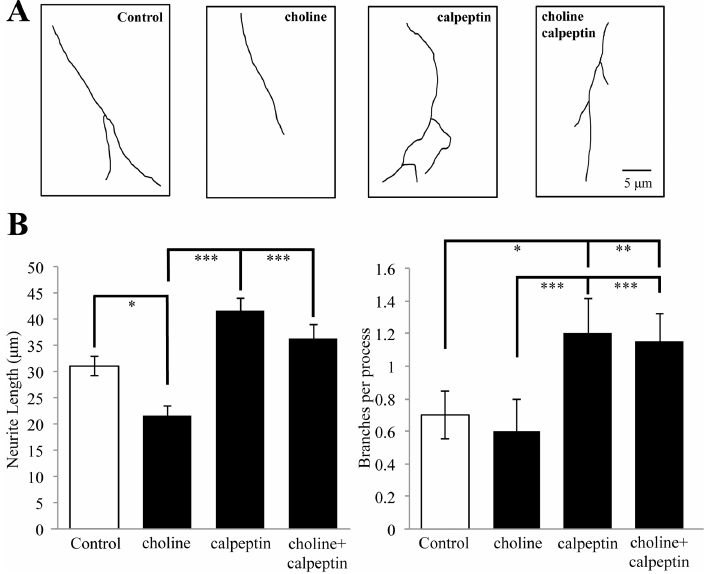
Fig 7. α 7 nAChRs regulate neurite outgrowth through calpain. (A) Representative traces of primary neurites in PC12 cells differentiated with NGF for 3 days in the presence of HBSS (Control), 1 mM choline, 26 μM calpeptin, or choline and calpeptin. (B) Average neurite length and branching in drug treated cells ( (cid:3) = p < 0.05, (cid:3)(cid:3) = p < 0.005, (cid:3)(cid:3)(cid:3) = p < 0.001; n = 20 cells per group).